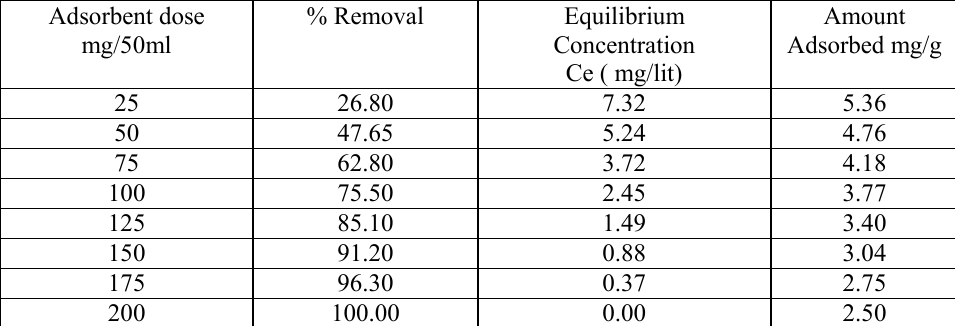
Table 4 . Quantity of chromium (VI) adsorbed and % removal at different doses of